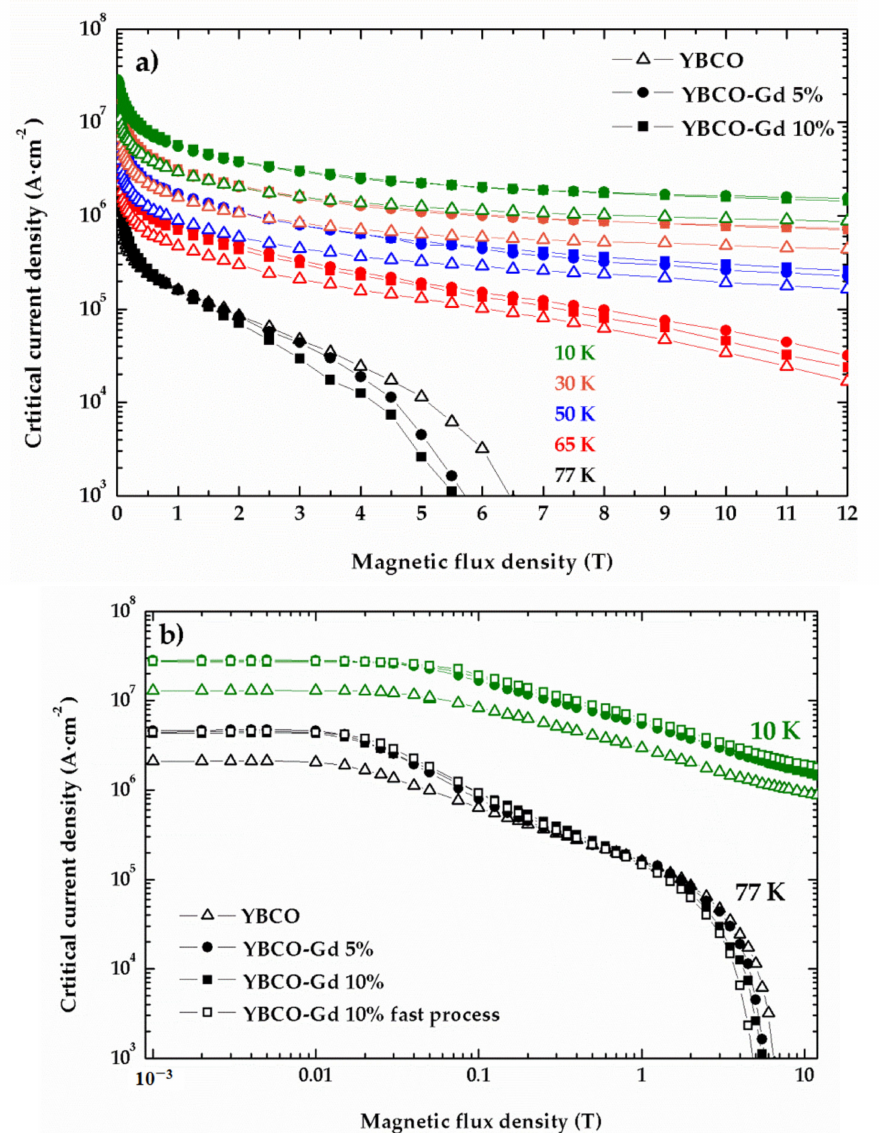
Figure 8. ( a ) Transport measurements of critical current density ( J c ) as a function of the applied magnetic field recorded for pristine YBCO (open triangle), YBCO-Gd 5% (full circle), and YBCO-Gd 10% (full square) films deposited with the standard process at several temperatures (77, 65, 50, 30 and 10 K) with H // c -axis condition. In ( b ), the same J c ( H ) curves, collected at 77 and 10 K for samples deposited with the standard process, were compared with YBCO-Gd 10% (open square) film grown by the fast